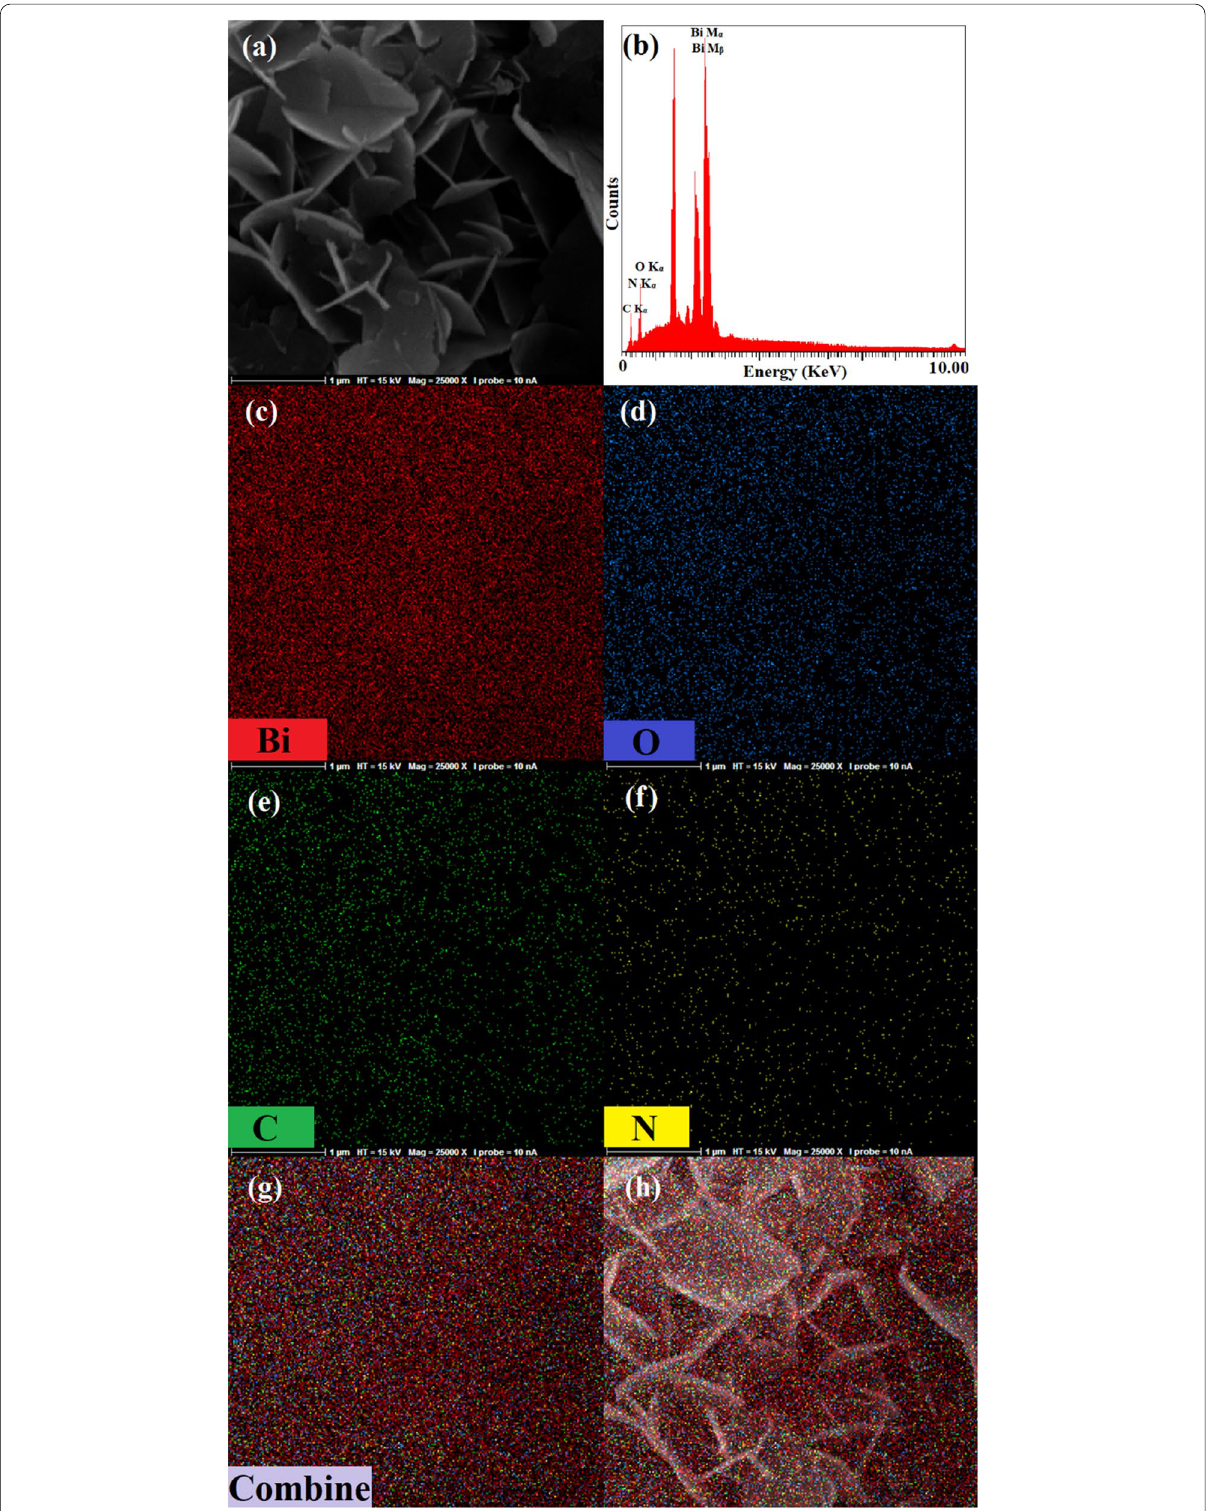
Fig. 4 a FE-SEM image, b EDS spectrum, elemental mapping patterns of c Bi, d O, e C, f N, g combine and h combine with FE-SEM image of Bi 2 O 3 / Bi 2 O 2 CO 3 /(BiO) 4 CO 3 (OH) 2